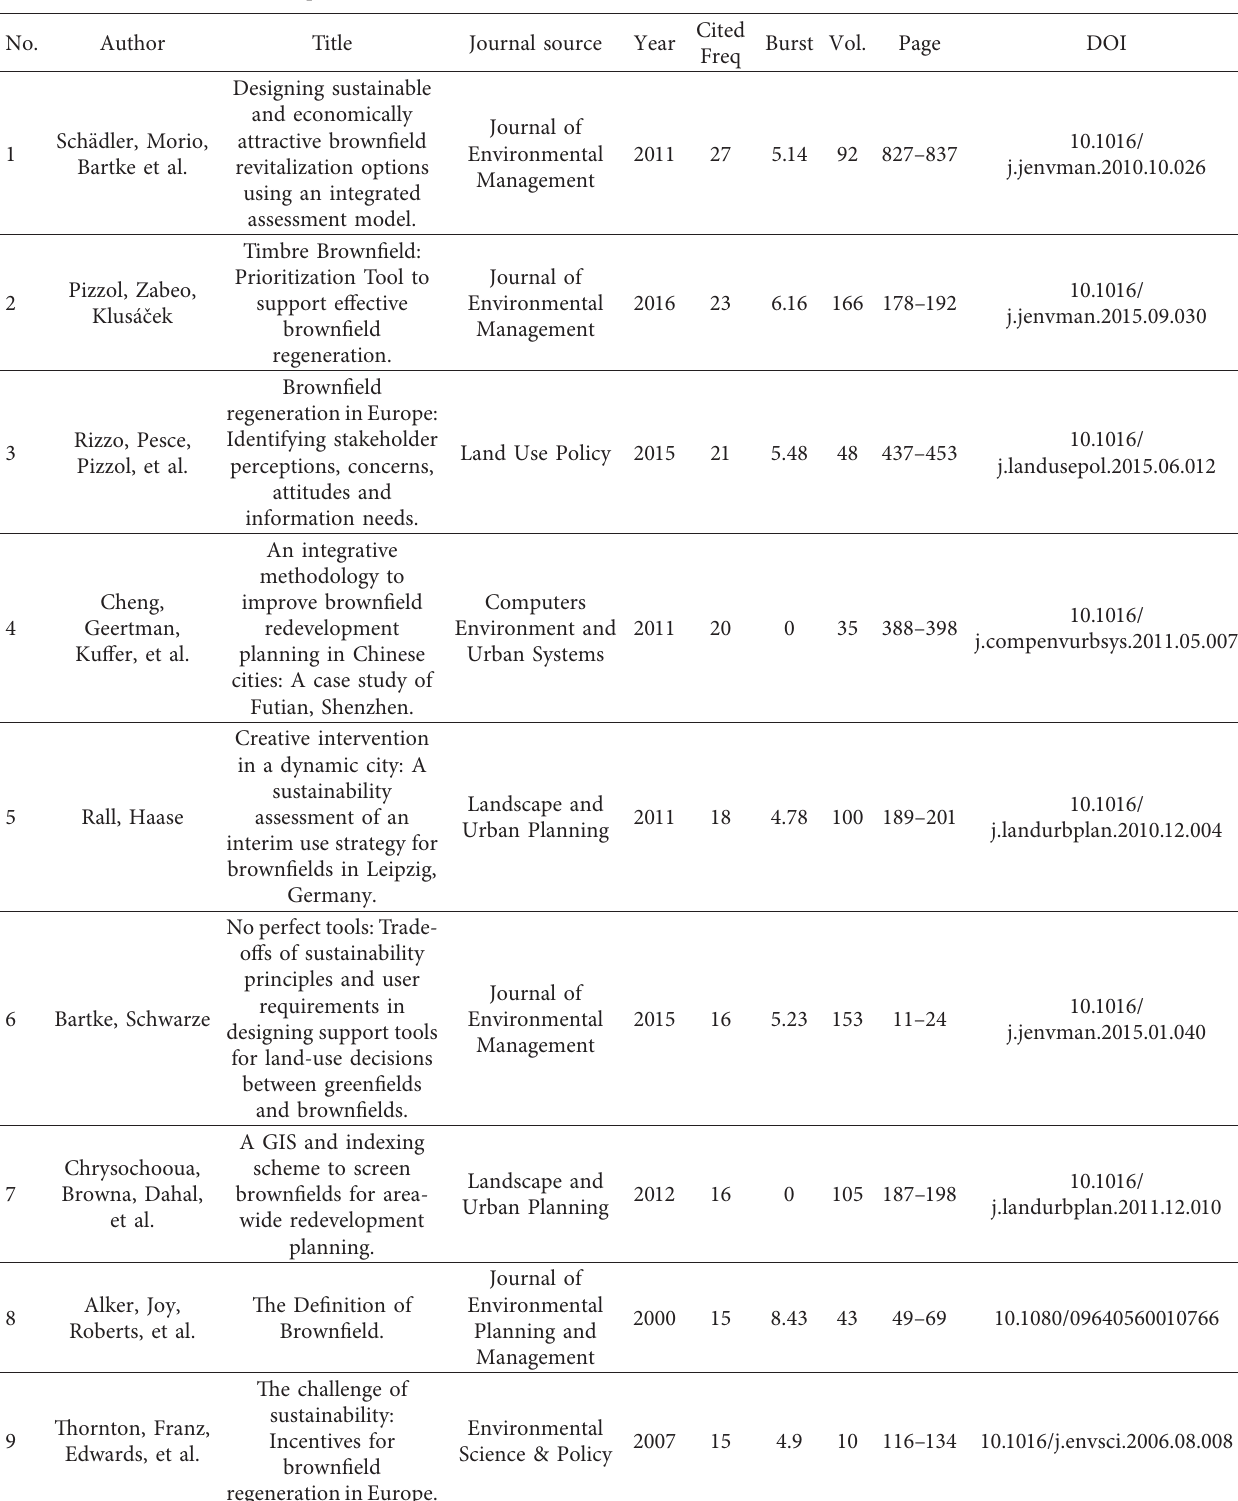
Table 3: The top 10 cocited documents in the document cocitation network in brownfield